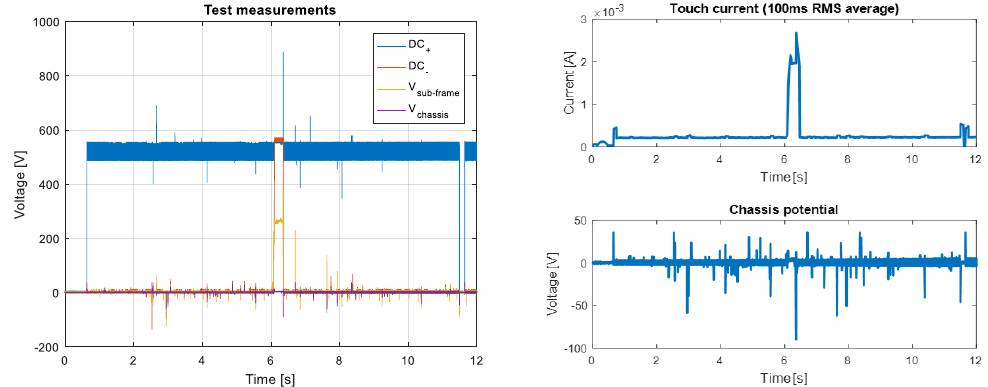
Figure 10. Measured voltages referred to earth ( left ), touch current RMS value over 100 ms ( right , top ), and chassis potential ( left , bottom ) under a loss of connection to the negative rail in winter conditions with guard-rail clamping diodes.